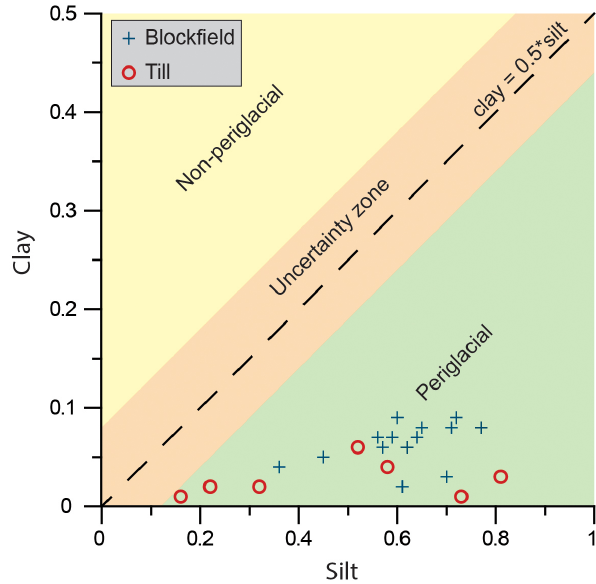
Figure 4. Quantities of clay and silt in fine matrix samples col- lected from blockfields (blue crosses) and till (red circles). All sam- ples contain clay/silt ratios less than 0.5, which indicates fine ma- trix production under conditions that have been, at least seasonally, periglacial (Goodfellow, 2012). Fine matrix samples falling in the uncertainty zone may have been exposed to periglacial conditions during their formation (Goodfellow, 2012). All data have been di- vided by 65 to fit on 0–1